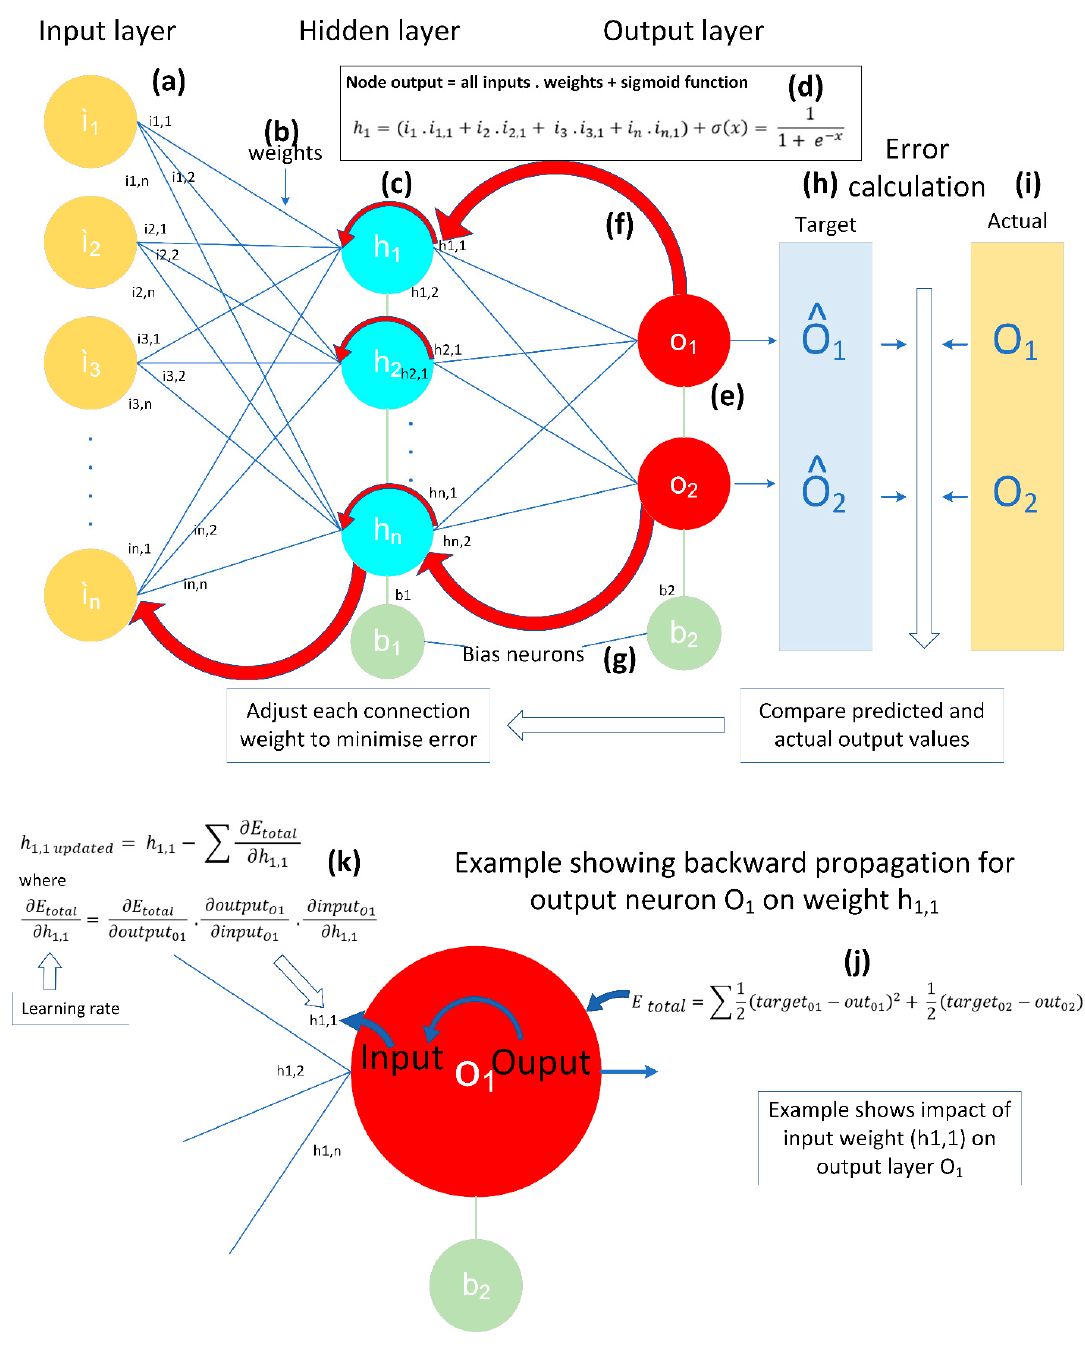
Figure 2. Top diagram shows the number of input, hidden and output layers implemented in the BPNN used in this study. The red arrow signifies the back propagation stage of the training process. Network inputs ( a ) consist of data glove sensor readings, ( b ) shows weights between each node and layer which are adjusted by the back propagation process as training progresses. ( c ) shows the hidden layer nodes which are carefully considered to avoid underfitting and overfitting. ( d ) demonstrates the mathematical function used to sum each layer’s inputs and calculate its sigmoid activation function. The backward propagation process then begins ( f ). The bias node is initialized, but is not influenced by inputs from previous layers ( g ). The output layer ( e ) compares the preferred pattern ( h ) with the hidden node outputs ( i ). Bottom diagram shows an example of the process needed to generate the total error for the current epoch ( j ) and the process to create a new weighed value for input h1,1 ( k ) using the sum of all inputs combined with a sigmoid function.